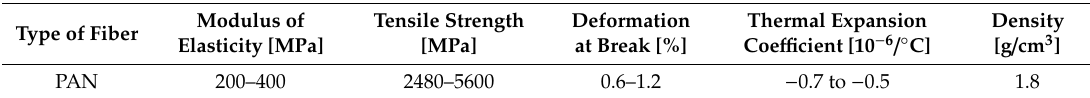
Table 1. Carbon fibers properties